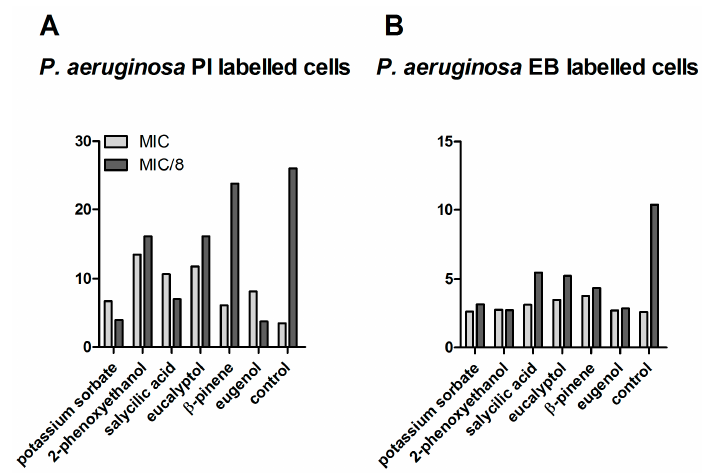
Figure 3. MFI for the analytical variants tested on P. aeruginosa strain ATCC 27853. ( A ) MFI for P.aeruginosa PI-labeled cells; ( B ) MFI for P.aeruginosa EB-labeled cells.